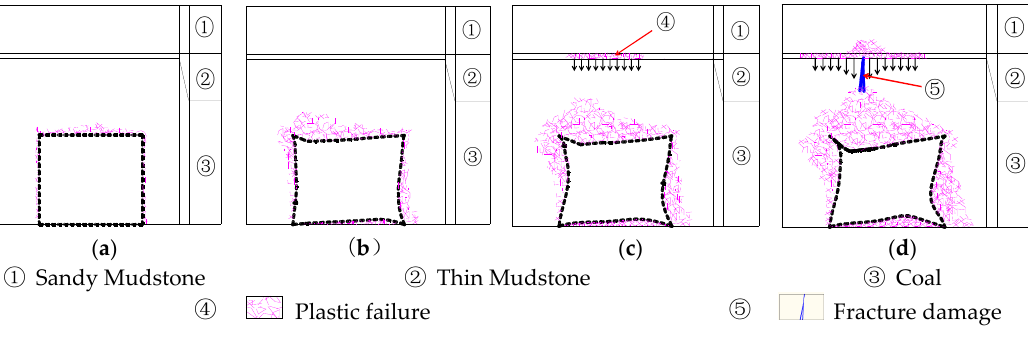
Figure 14. Deformation and failure development process of roadway compound roof. 5. Field